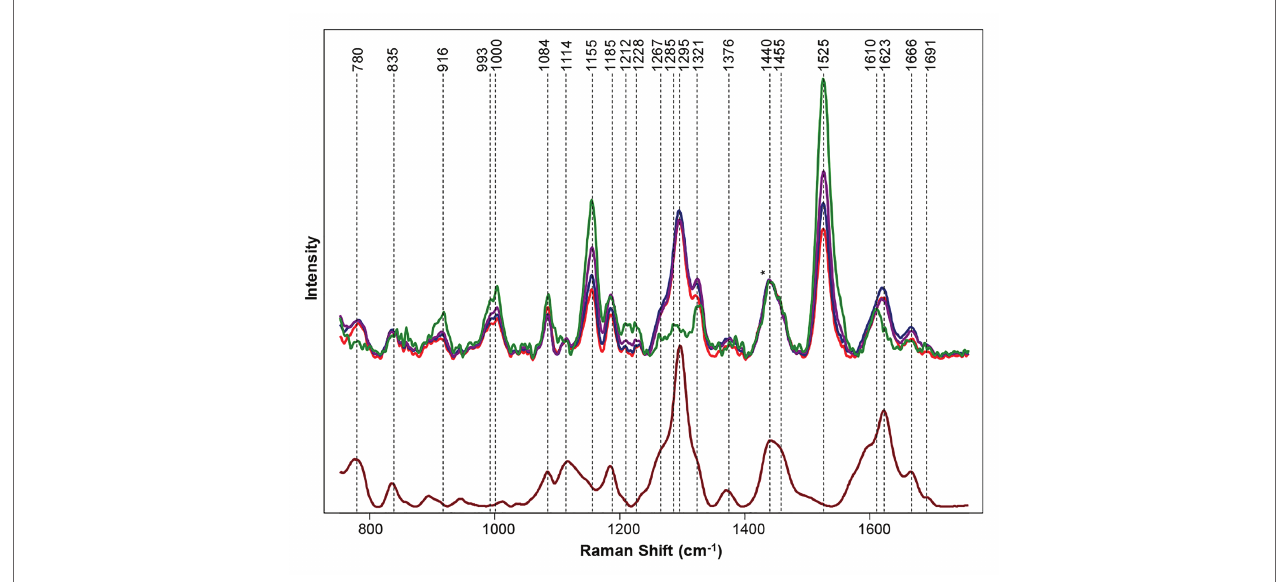
FIGURE 10 | Top: Raman spectra collected from hemp (green), GC (purple), TCC (blue), and TS (red). Bottom: Raman spectrum of THCA extract (maroon). Spectra normalized on CH 2 vibrations (1,440 and 1,455 cm −1 ) are present in nearly all classes in biological molecules [marked by asterisks (*)]. Reproduced with permission from Sanchez et al.